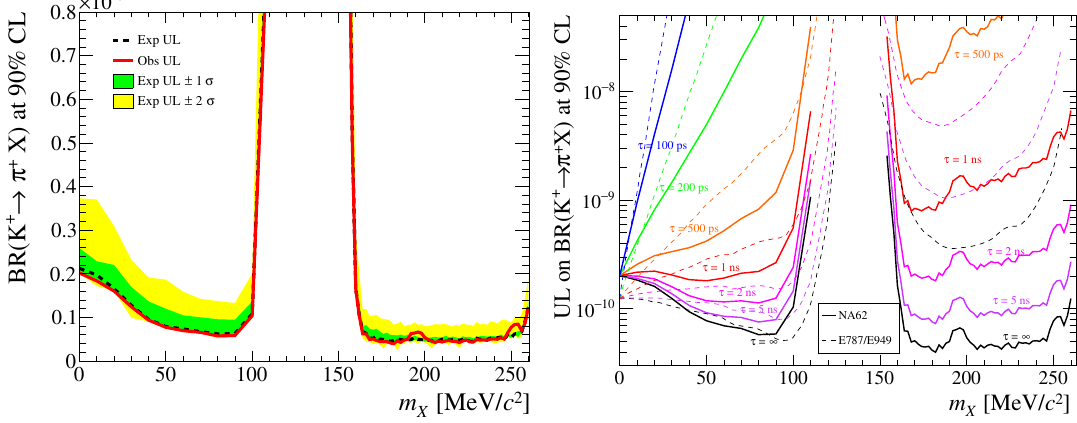
Figure 4 . Left: upper limits on BR ( K + → π + X ) for each mass hypothesis, m X , tested. Right: model-independent observed upper limits as functions of the mass and lifetime assumed for X for NA62 (this work, solid lines) and E787/E949 [23] (dashed